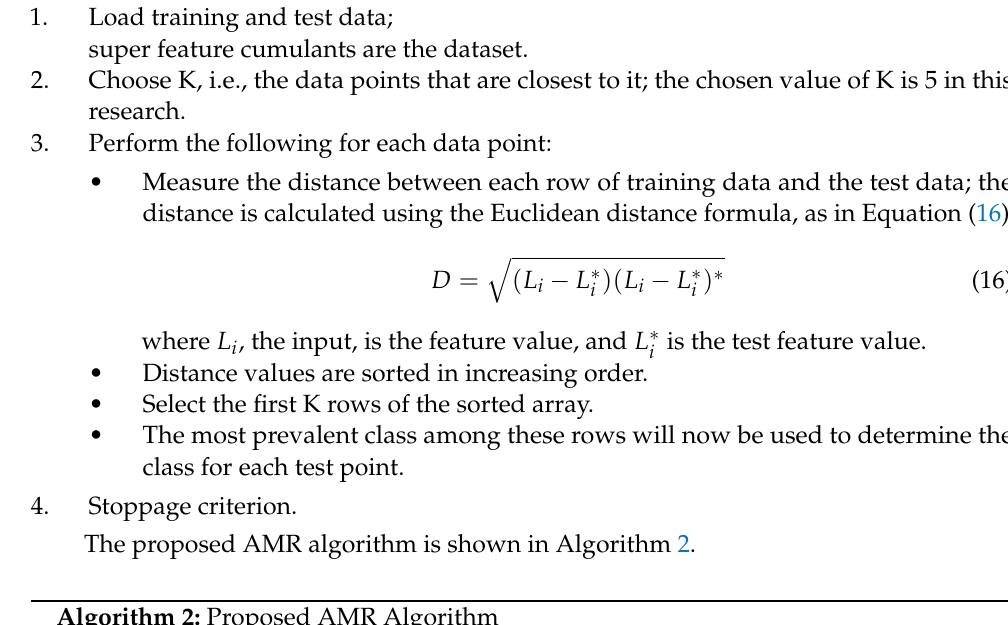
Algorithm 2: Proposed AMR